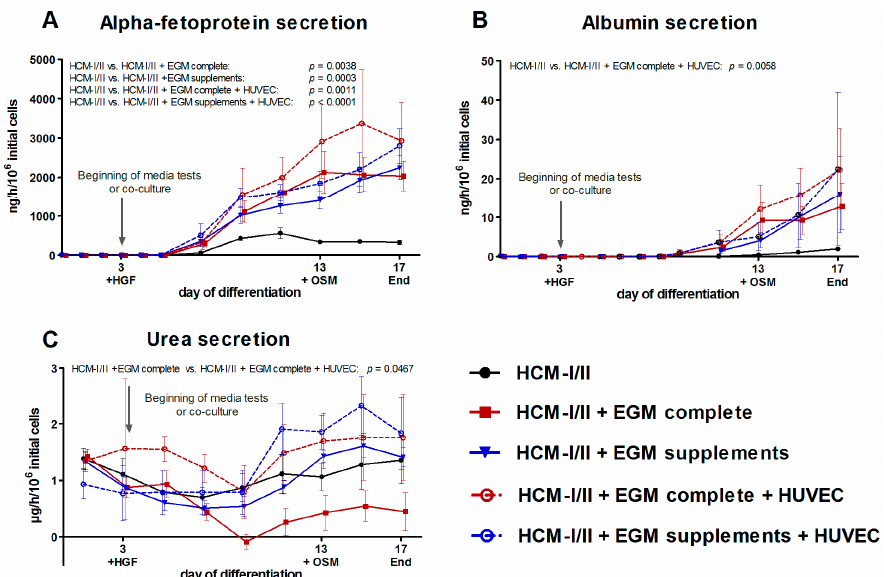
Figure 7. Effect of different media compositions and/or co-culture with human umbilical vein endothelial cells (HUVEC) on secretion of stage-specific markers during differentiation of human induced pluripotent stem cells (hiPSC). Differentiation of definitive endodermal cells was performed over 14 days using hepatocyte culture medium (HCM-I/II), a 1:1 mixture of hepatocyte culture medium and endothelial cell growth medium, consisting of basal medium and supplements (HCM-I/II + EGM complete) or HCM enriched with endothelial cell growth supplements (HCM-I/II + EGM supplements) with or without HUVEC addition. Graphs show the secretion of α -fetoprotein (AFP, A ), secretion of albumin ( B ) and secretion of urea ( C ). The area under the curve was calculated and differences between HCM and all other groups as well as differences between test media and their corresponding co-cultures were detected using the unpaired, two-tailed Student’s t -test, n = 8; Co-cultures: n = 3; mean ± standard error of the mean.